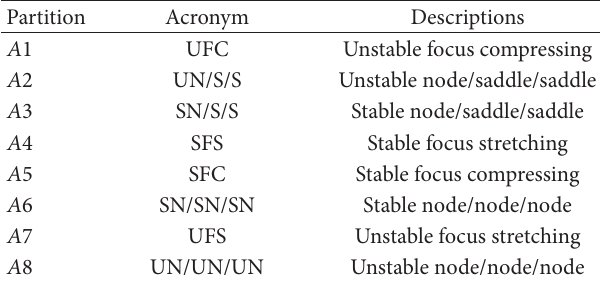
Table 1: Acronyms and descriptions of various flow partitions and topologies [15].